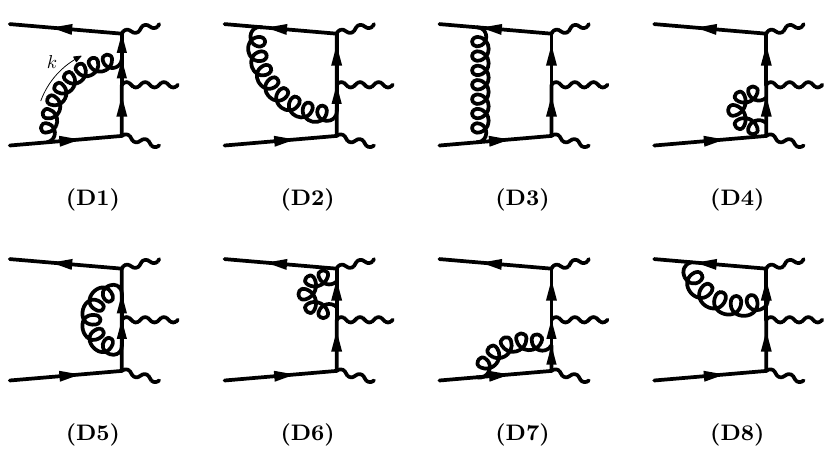
Figure 15. Diagrams contributing to one-loop QCD correction to q (cid:22) q